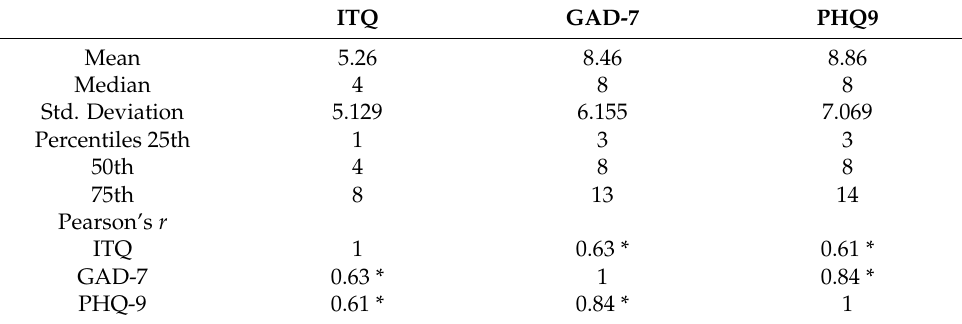
Table 4. Statistics for the psychometric